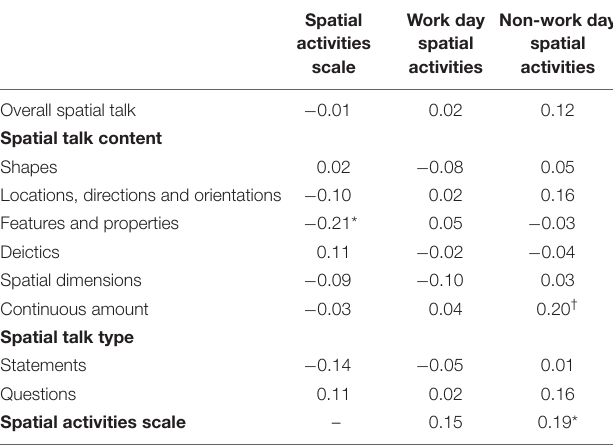
TABLE 11 | Associations among spatial talk content from the semi-structured observations, home spatial activities scale, and spatial activities reported on work and non-work days from the time diary